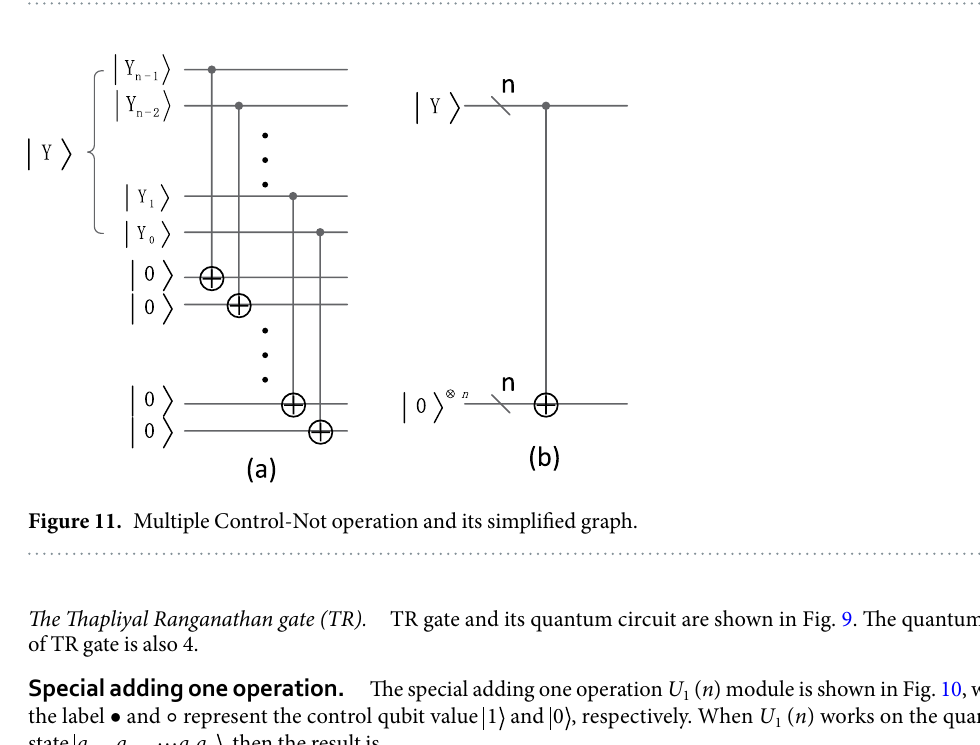
Figure 10. Quantum circuit of U 1 (n) module and its simplified graph.